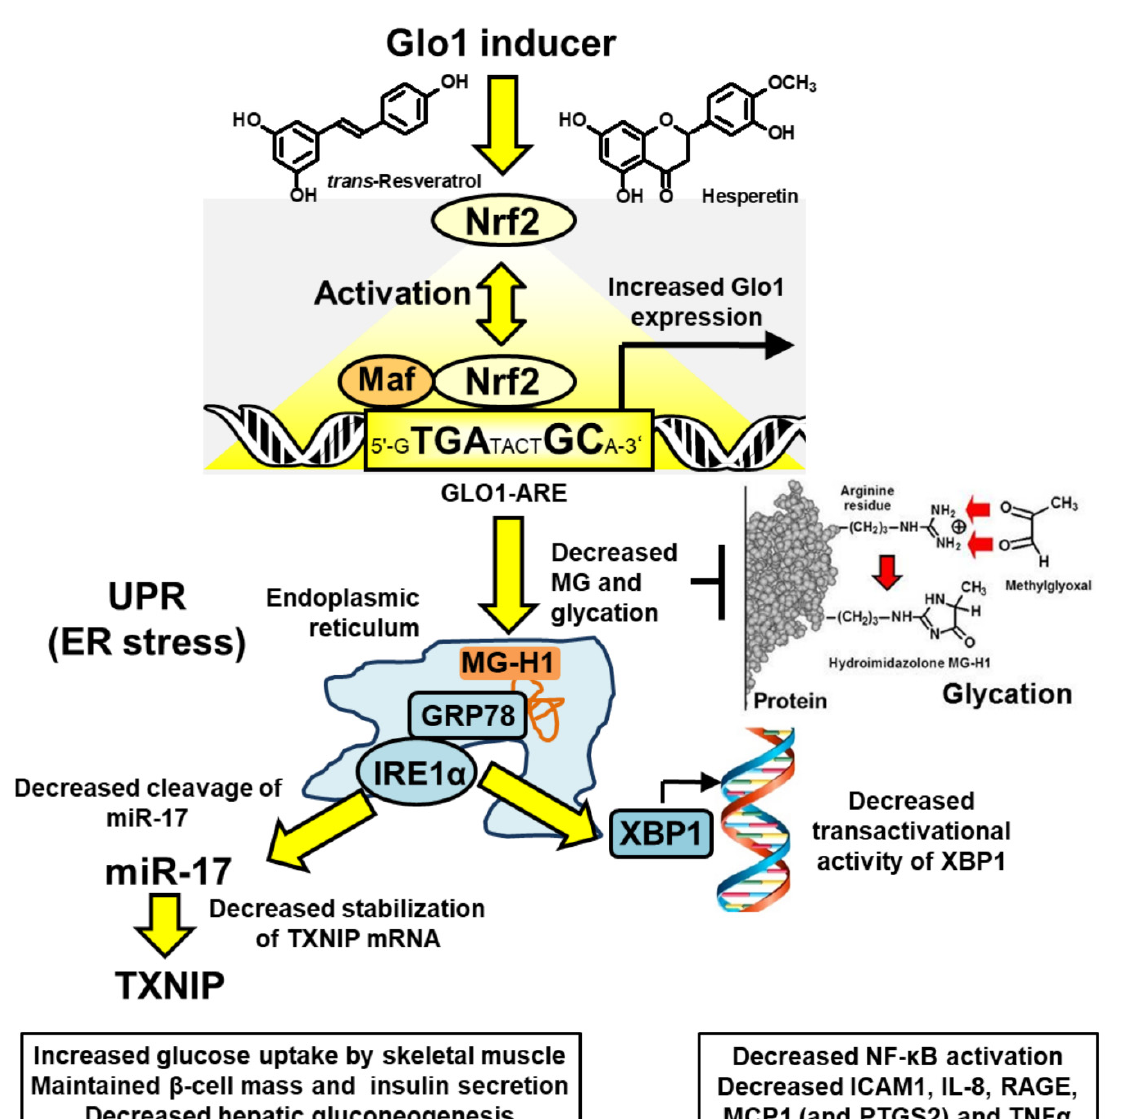
Figure 2. Proposed mechanism of action of Glo1 inducer, tRES-HESP, through suppression of the unfolded protein response. Key: yellow filled arrows—mechanism of health improvement by; red filled arrows—damaging processes suppressed. See text for details. Abbreviations: GRP78, 78 kDa glucose-regulated protein; IRE1 α ; inositol regulated enzyme-1 α ; Maf, basic region leucine zipper-type transcription factor; miR-17. microRNA-17; Nrf2, nuclear factor-erythroid factor 2-related factor 2; TXNIP, thioredoxin-interacting protein; XBP1, X-box binding protein-1. Modified and reproduced with permission from [50]. Table 1. Pharmacological activity of glyoxalase 1 inducer, trans -resveratrol and hesperetin, in pre- clinical disease models and clinical trial.